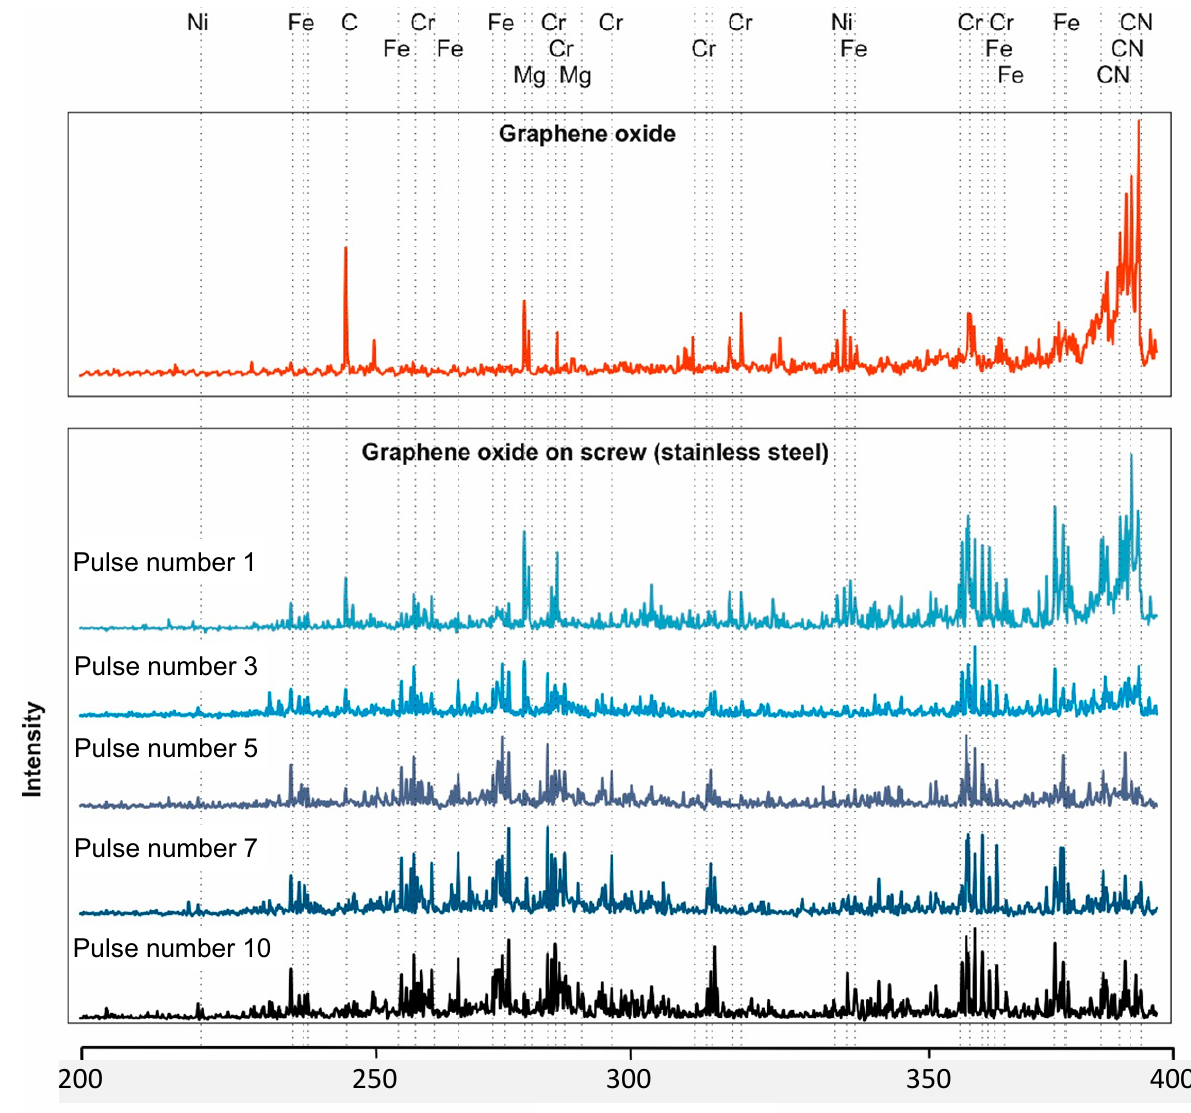
Figure 5. LIBS spectra of graphene oxide deposited on a thread made from steel 316L obtained with a different number of laser beam pulses and related to the spectrum of graphene oxide.